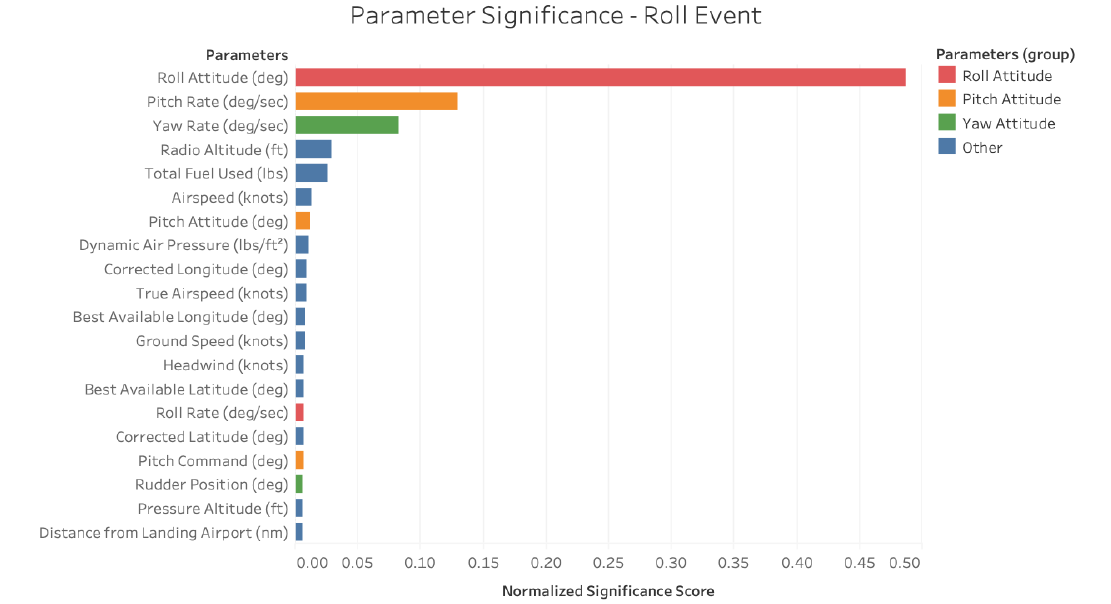
Figure 13. Normalized critical parameter significance for the Roll Event obtained from application of SAFE framework.